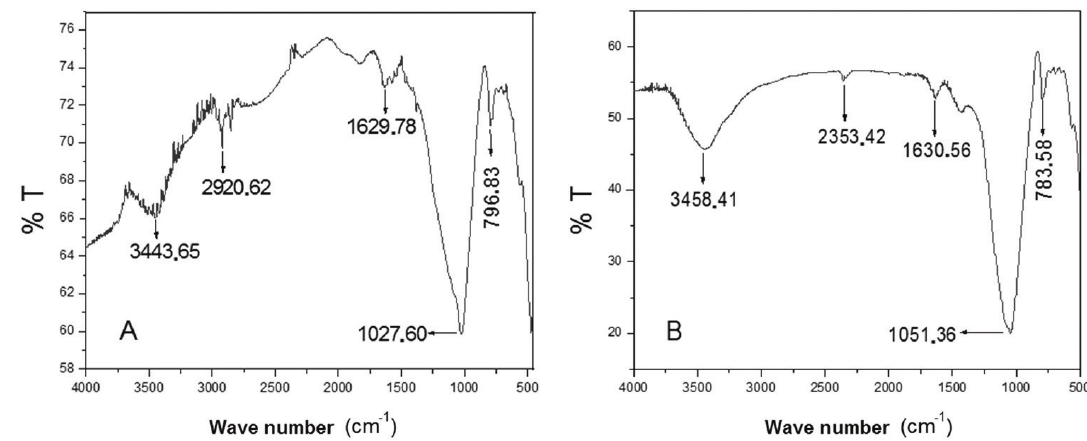
Figure 7. Spectra for FTIR of (a) Fluidgel TACal and (b) Fluidgel TACal +